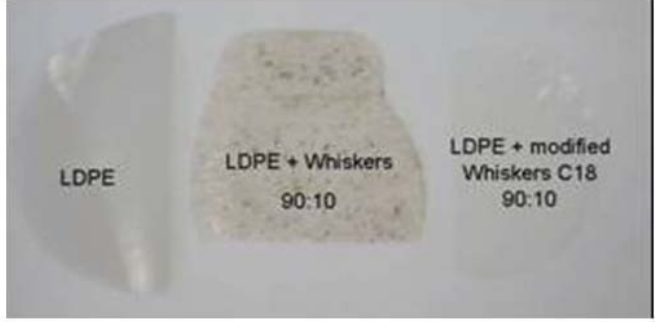
Figure 6. Photographs of the neat LDPE film and extruded nanocomposite films reinforced with 10 wt % of unmodified and C18 acid chloride-grafted cellulose whiskers